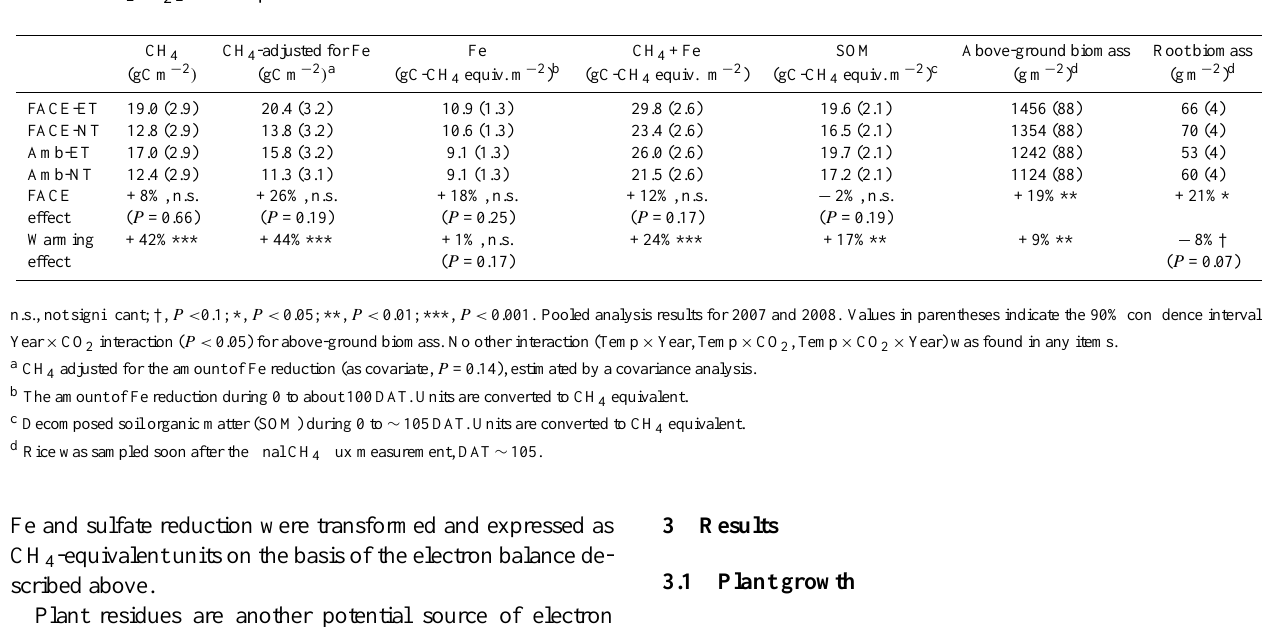
Table 2. Seasonal CH 4 emission (raw data and adjusted for Fe reduction), Fe reduction, SOM decomposition, and end-of-season rice biomass for different [CO 2 ] and temperature